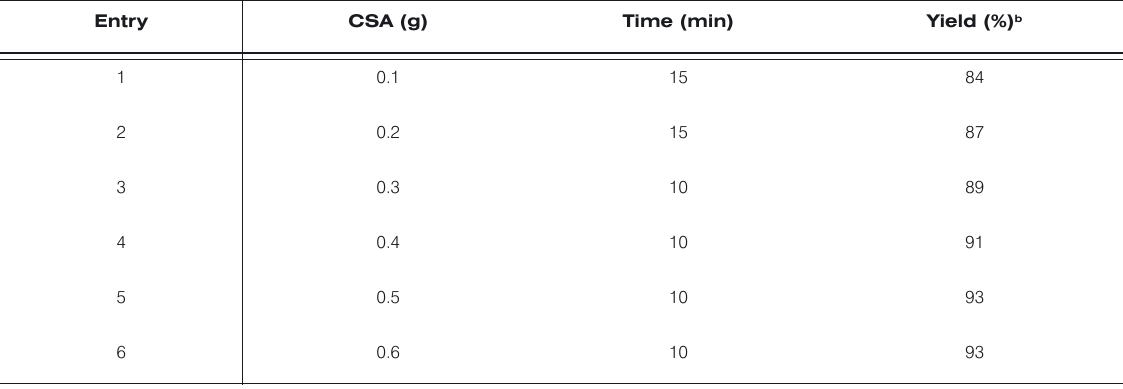
Table 1. Effect of proportion of CSA for the synthesis of 2,2-dimethyl-5-[(4-oxo-4H-chromen-3-yl) methylene]-1,3-dioxane-4,6-dione a [Table 2, entry 3a] from 1 mmol each of Meldrum’s acid and